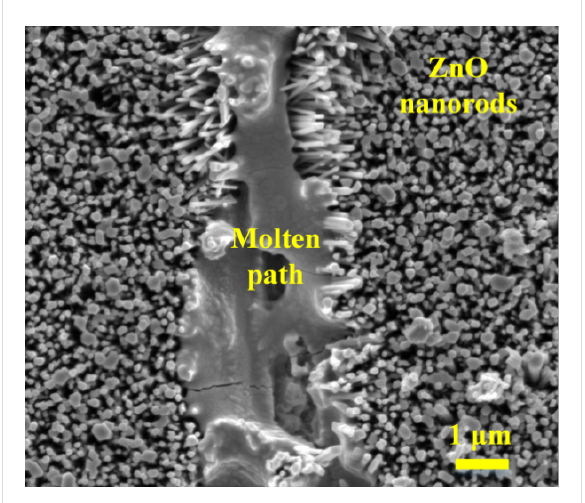
Figure 7: Scanning electron microscope image of the molten path due to the current flow between the contacts after a DC test showing evi- dence of melting and recrystallization of the material under electrical stress.